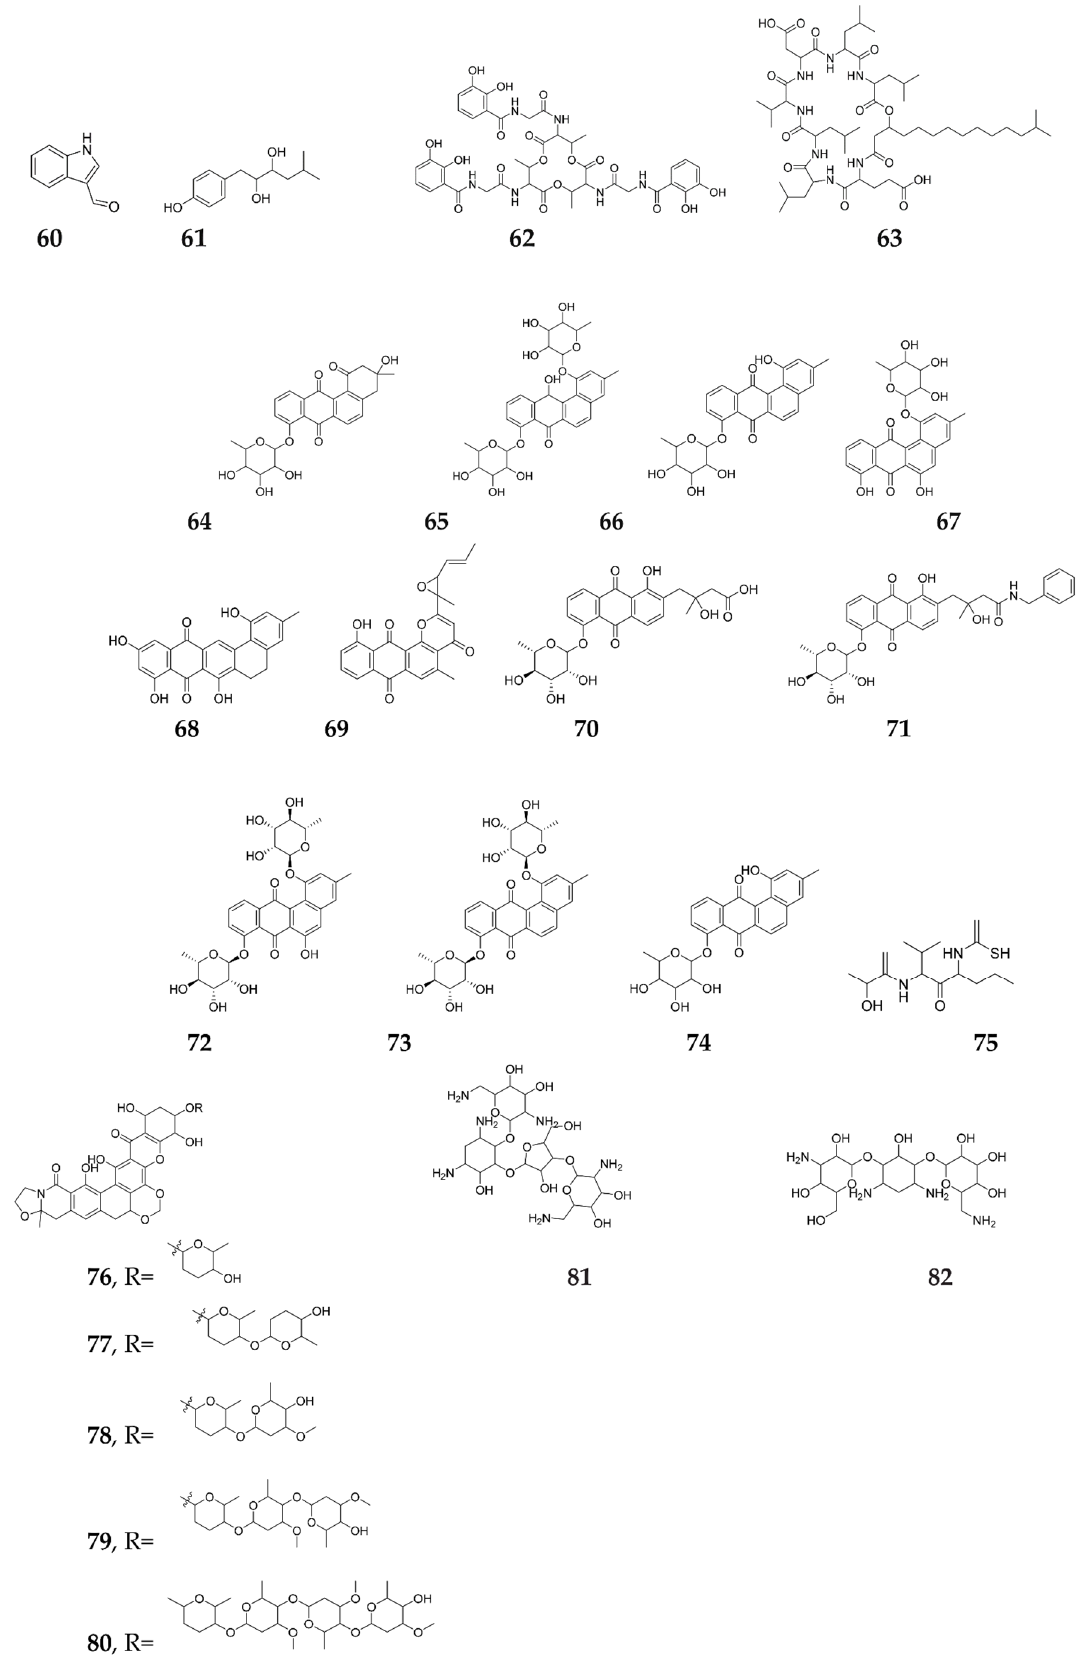
Figure 7. Secondary metabolites elicited by metabolic signals (GlcNAc and siderophores).